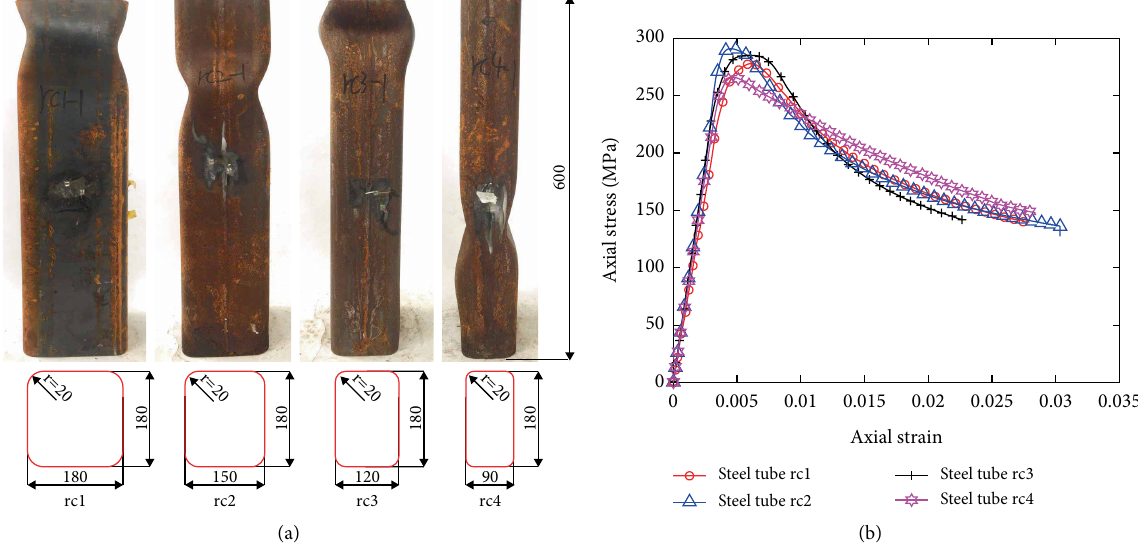
Figure 6: Axial compression test of rectangular hollow steel tubes. (a) Rectangular hollow steel tubes. (b) Axial stress-strain